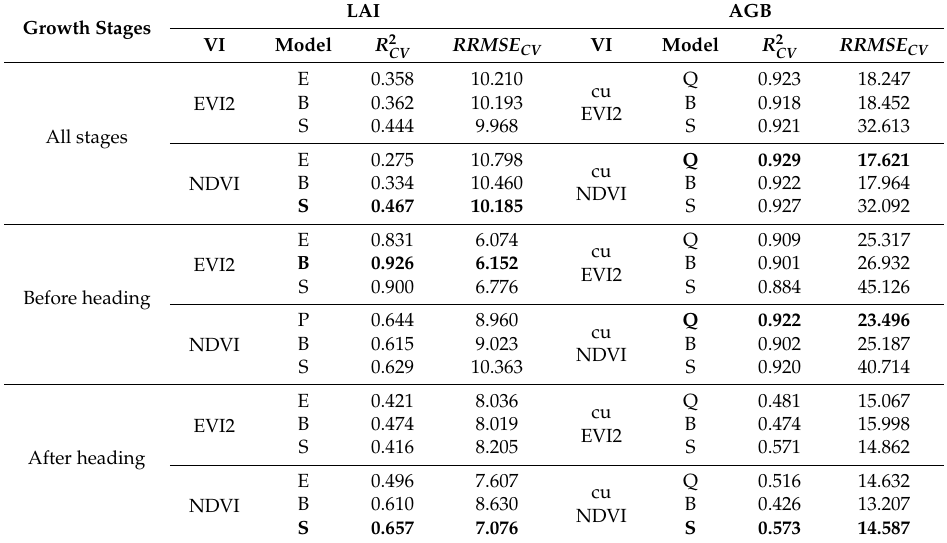
Table 4. Results of regression models at different single-cropped rice (SCR) growth stages.